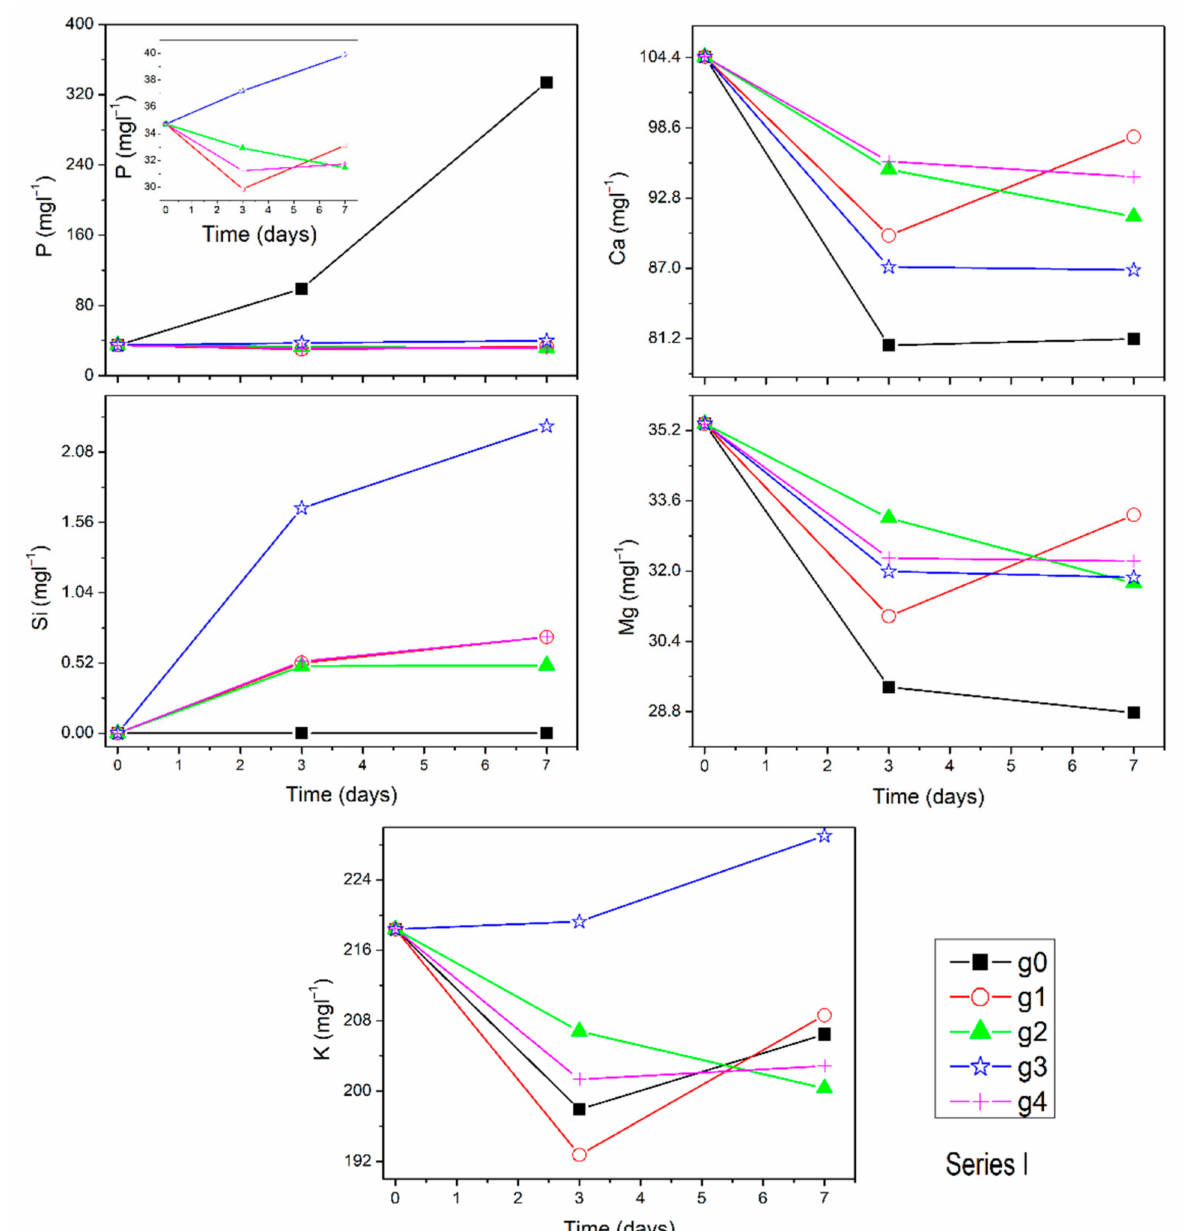
Figure 2. Ion dissolution profiles of series I samples in SBF under static conditions as function of immersion time. Error bars are included in the points’